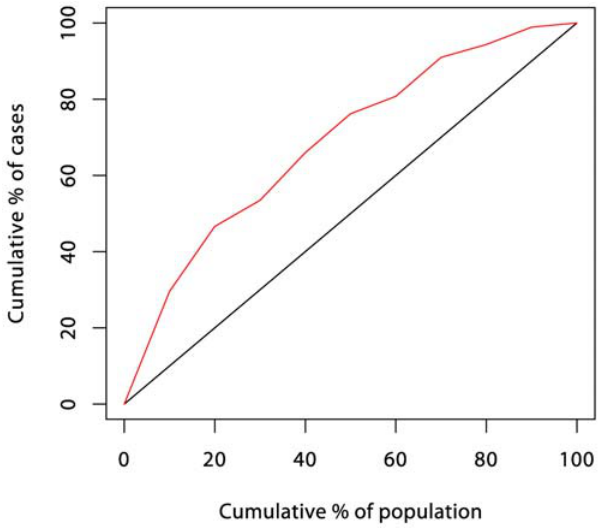
Figure 1. ROC curve for the prediction score of Truett, Cornfield, and Kannel [ 2 ] (five- year incidence of coronary heart disease in the Framingham cohort study).